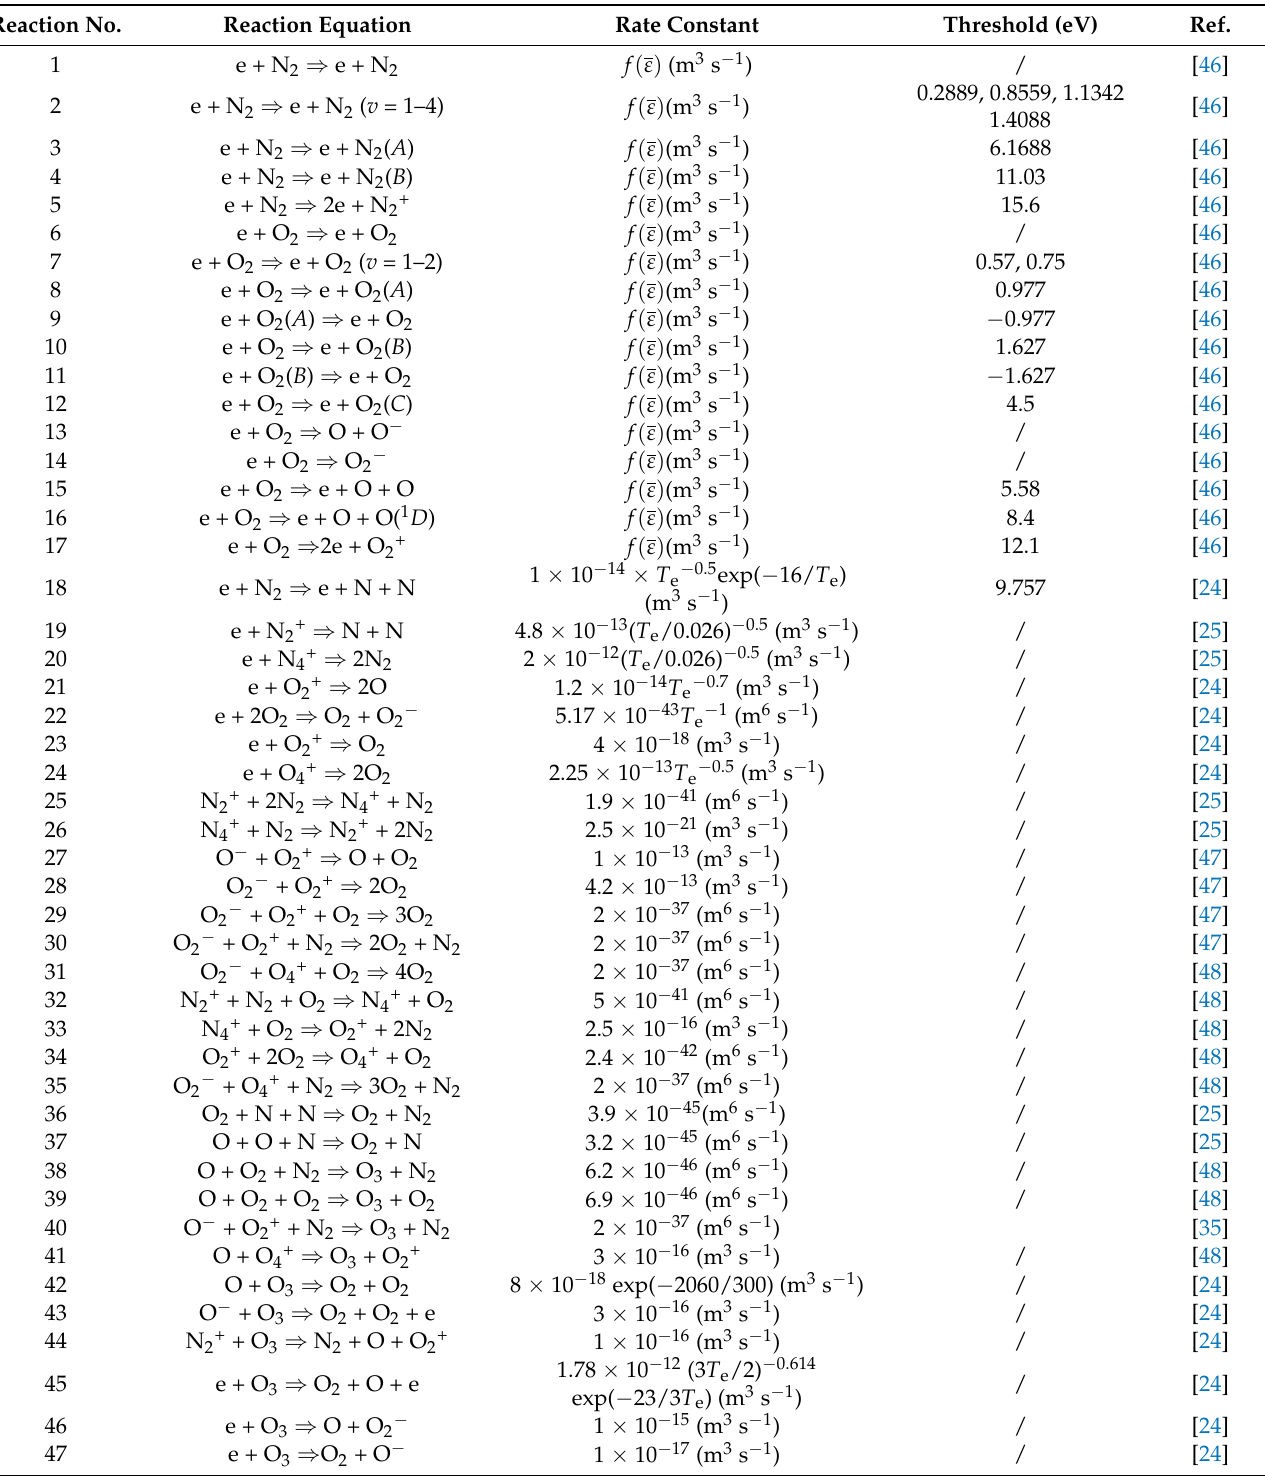
Table A1. Gas-phase reactions considered in the